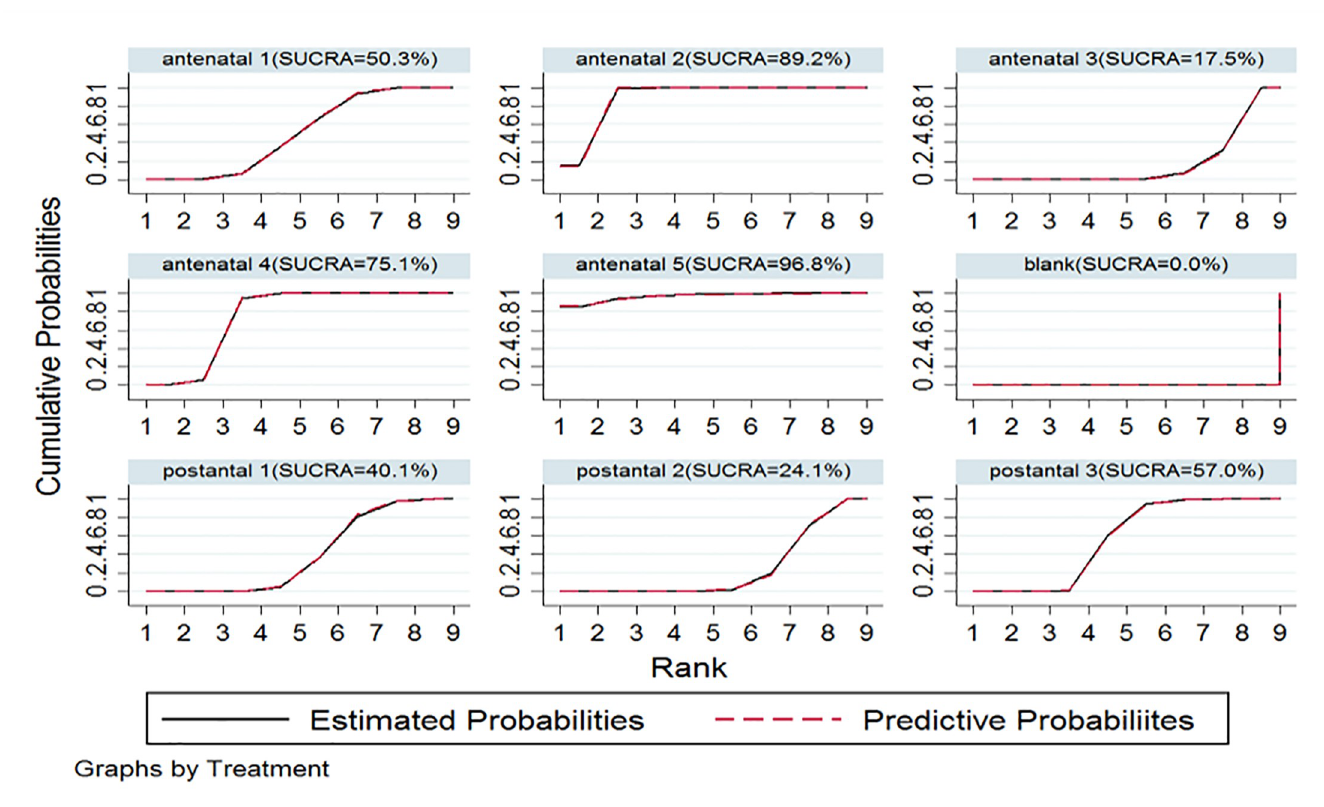
Fig 5. SUCRA for preventing maternal antibody sensitization.